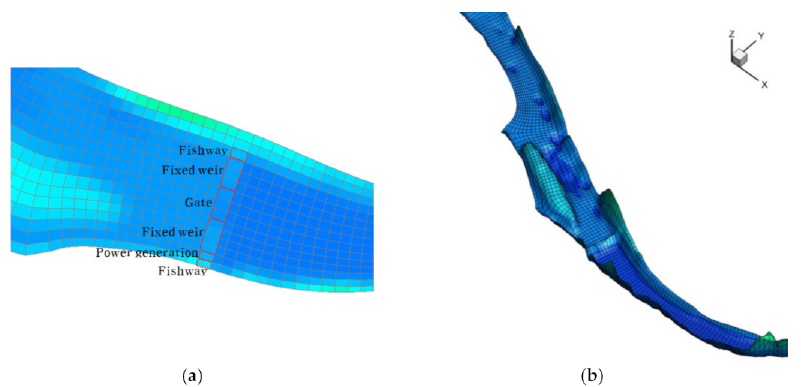
Figure 6. Changnyeong-Haman Weir: ( a ) Application of multifunctional weir hydraulic structure module; ( b ) Terrains around the Changnyeong-Haman